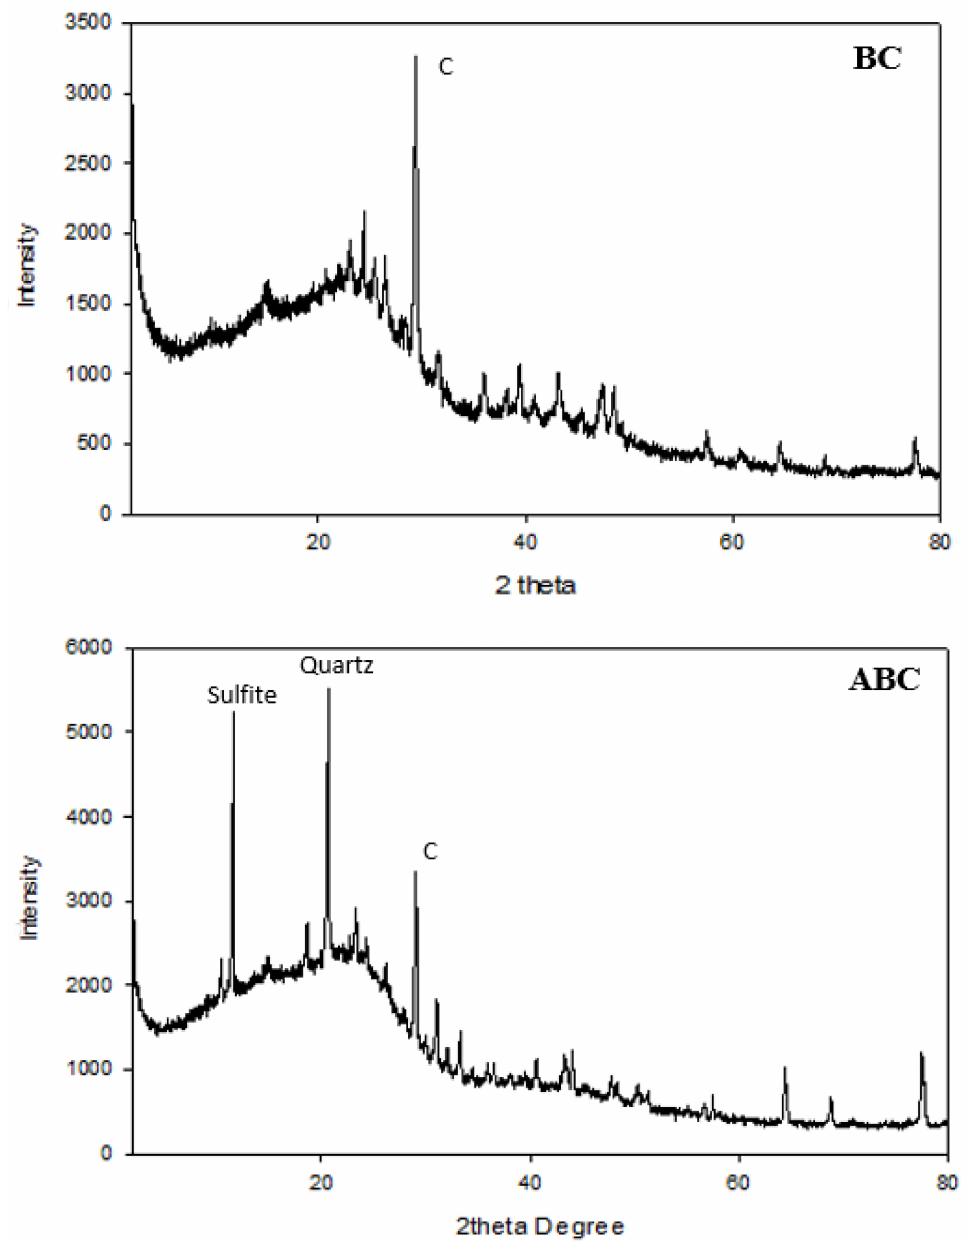
Figure 2. X-ray diffraction analyses of biochar (BC) and acidified biochar